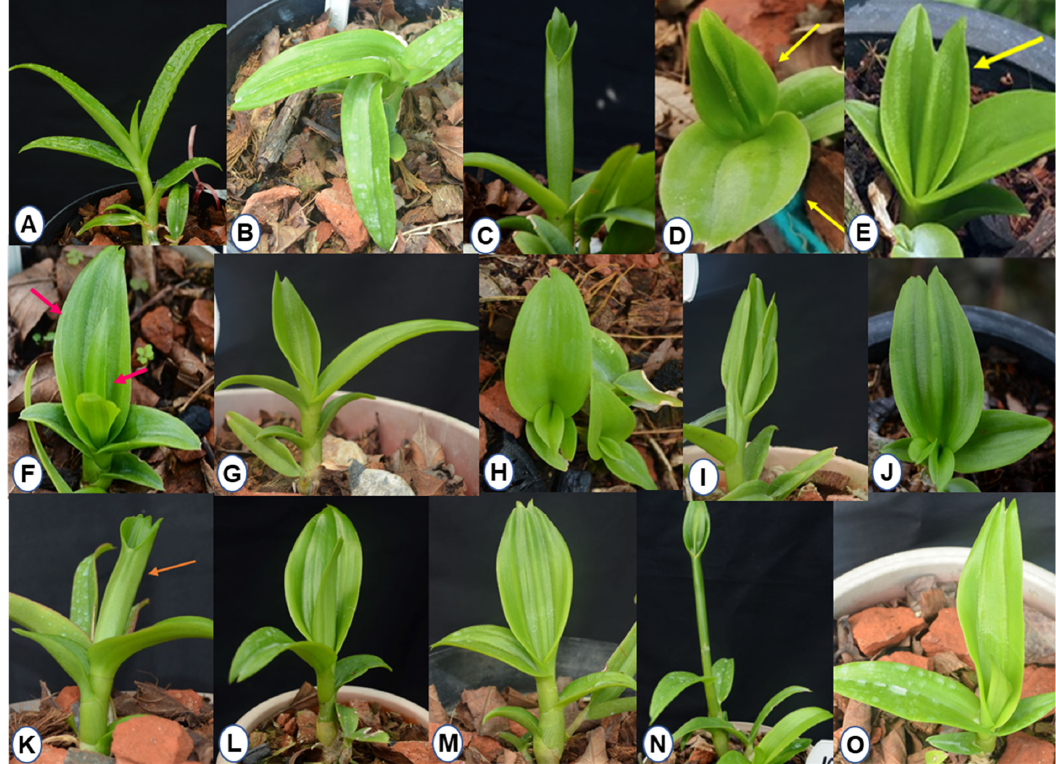
drogram constructed using Nei’s dissimilarity coefficient by UPGMA-based clustering method showed three major clusters (I, II, III), with a cophenetic correlation coefficient of 0.89. Cluster I included mutants of 20 Gy_1, 2, 3 and 40 Gy_1, 3, including two controls of ‘Emma White’ C_1, 2; cluster II included mutants of 10 Gy_3 and 40 Gy_2, whereas cluster III included three mutants of 10 Gy_1, 2, 4.